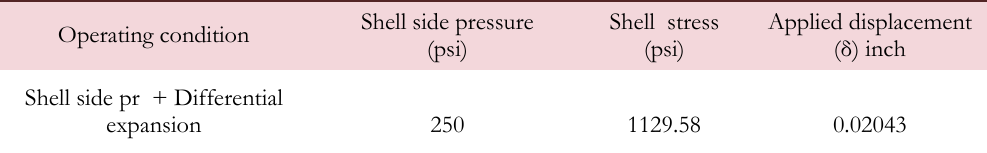
Table 2: Operating